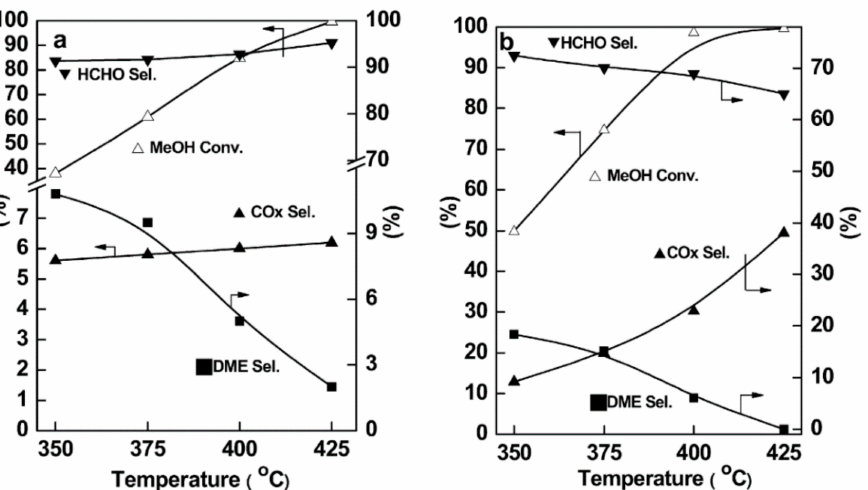
Figure 31. Catalytic conversion and selectivity of ( a ) 5.3 wt% V 2 O 5– 19.5 wt% Sb 2 O 5 /SiO 2 and ( b ) 5.4 wt% V 2 O 5 /SiO 2 catalysts as function of temperature. Reprinted from [199] Copyright © (2008), with permission from